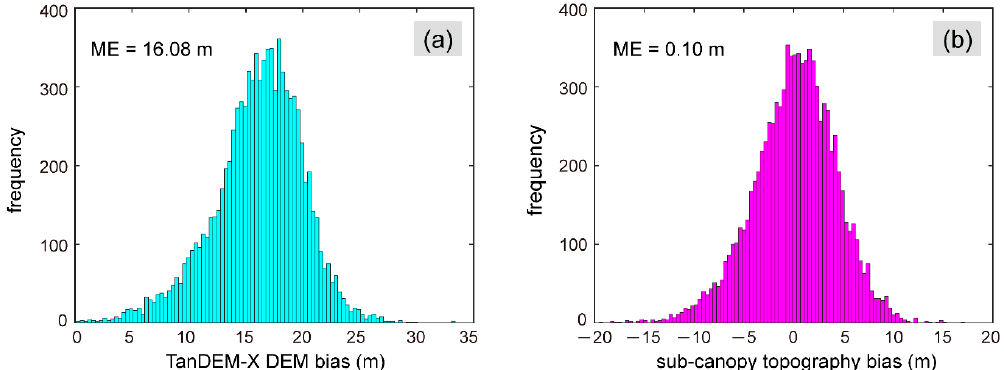
Figure 6. Histograms of the elevation bias: ( a ) Original TanDEM-X DEM; ( b ) Sub-canopy topography.